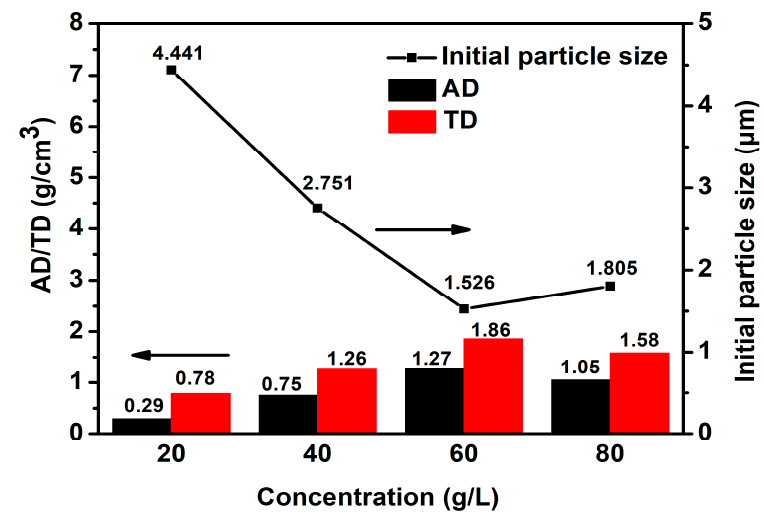
Figure 1. Variation of initial particle size, and the apparent density (AD) and tap density (TD) with concentration changes of the base solution .